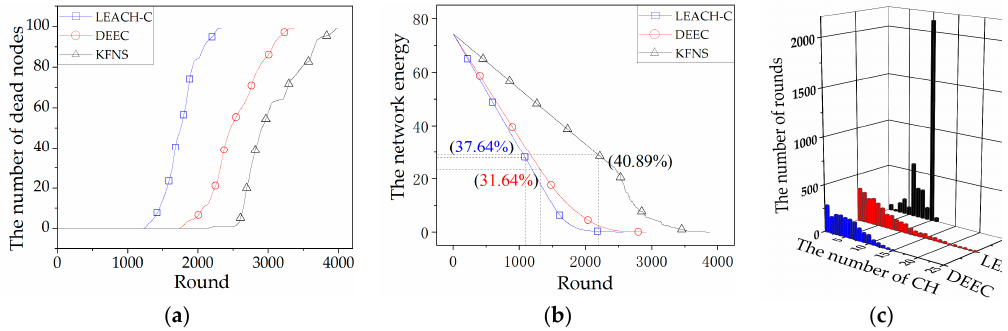
Figure 7. ( a ) The curves of dead node number by rounds; ( b ) network energy consumption; ( c ) number of cluster heads and boundary nodes.